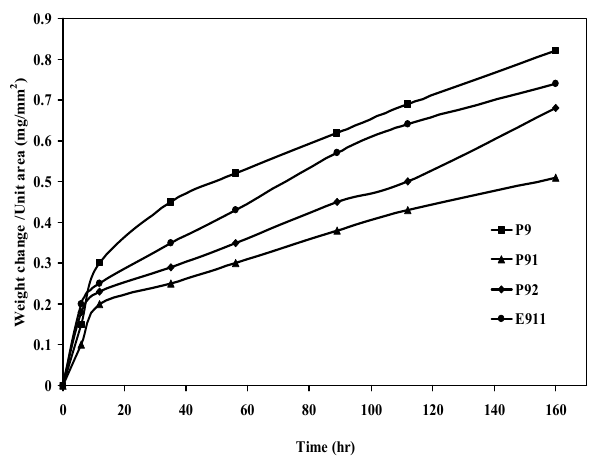
Figure 9. Weight change vs. time plots for alloys oxidized at 1073 K in O 2 C 50 % H 2 O.